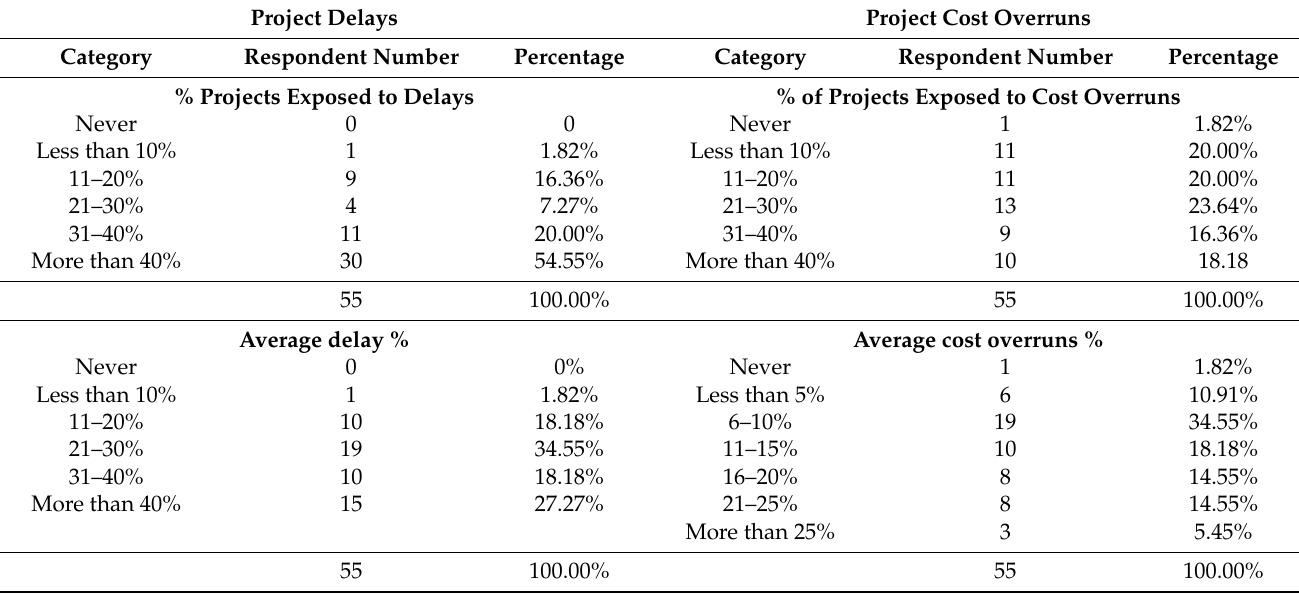
Table 2. Performance of building construction projects.